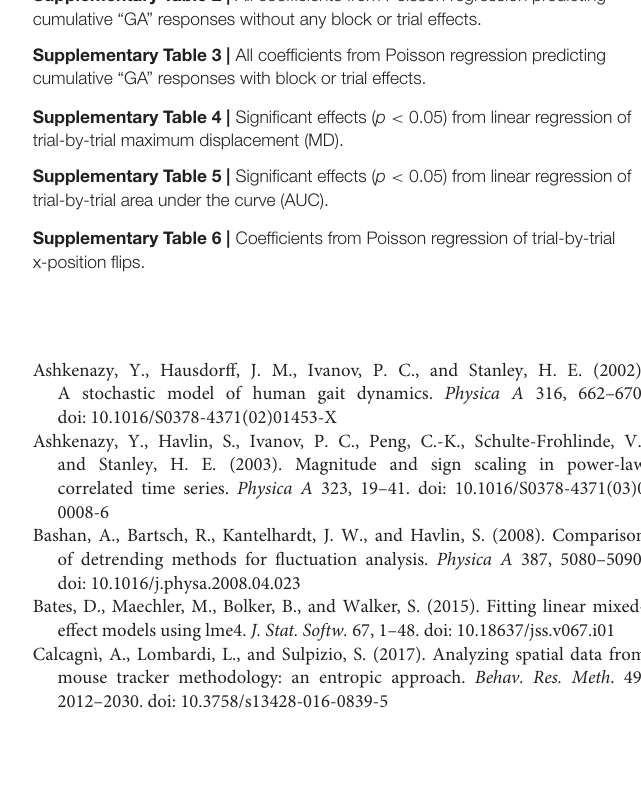
Supplementary Figure 2 | Model predictions representing the effects of multifractal-based nonlinear estimate t MF as well as its interactions with Precursor, with entropy measures ψ and ξ on the mouse-tracking measure of maximum displacement (MD). These ψ × ξ × t MF × Precursor interaction effects on MD manifested differently across all context conditions: in real-speech context (left panel), in simulated-speech context (top right panel), and the tone context (bottom right panel). In all panels, interaction effects appear in solid lines (for Precursor [al]) or in dashed lines (for Precursor [a ô ]), in black (for low ψ ) or in gray (for high ψ ), and with circle markers (for high ξ ) or without circle markers (for low ξ ). Supplementary Figure 3 | Model predictions representing the effects of multifractality W MF × t MF as well as its interactions with Precursor, with entropy measures ψ and ξ on the mouse-tracking measure of area under the curve (AUC). These ψ × ξ × W MF × t MF × Precursor interaction effects on AUC manifested differently across all context conditions: in real-speech context (left panel), in simulated-speech context (top right panel), and the tone context (bottom right panel). In all panels, interaction effects appear in solid lines (for Precursor [al]) or in dashed lines (for Precursor [a ô ]), in black (for low ψ ) or in gray (for high ψ ), and with circle markers (for high ξ ) or without circle markers (for low ξ ). Supplementary Figure 4 | Model predictions representing the effects of multifractality W MF and its interactions with slow entropy ψ × W MF , with fast entropy ξ × W MF , and with precursor Precursor × W MF on x-position flips. Panels show predictions specific to real-speech contexts (top left and in solid black), simulated-speech contexts (top right and in dashed black), and tone contexts (bottom right and in solid gray). Predictions for Precursor [al] appear as filled bars whereas predictions for Precursor [a ô ] appears empty bars. To show the range of multifractal properties in the simulated-speech cases, predictions appears for simulated-speech contexts with higher W MF and higher t MF appearing with higher-frequency dashes composing the borders and the filling of the bars. Supplementary Table 1 | All coefficients from logistic regression predicting “GA” vs. “DA” without any block or trial effects. Supplementary Table 2 | All coefficients from Poisson regression predicting cumulative “GA” responses without any block or trial effects. Supplementary Table 3 | All coefficients from Poisson regression predicting cumulative “GA” responses with block or trial effects.